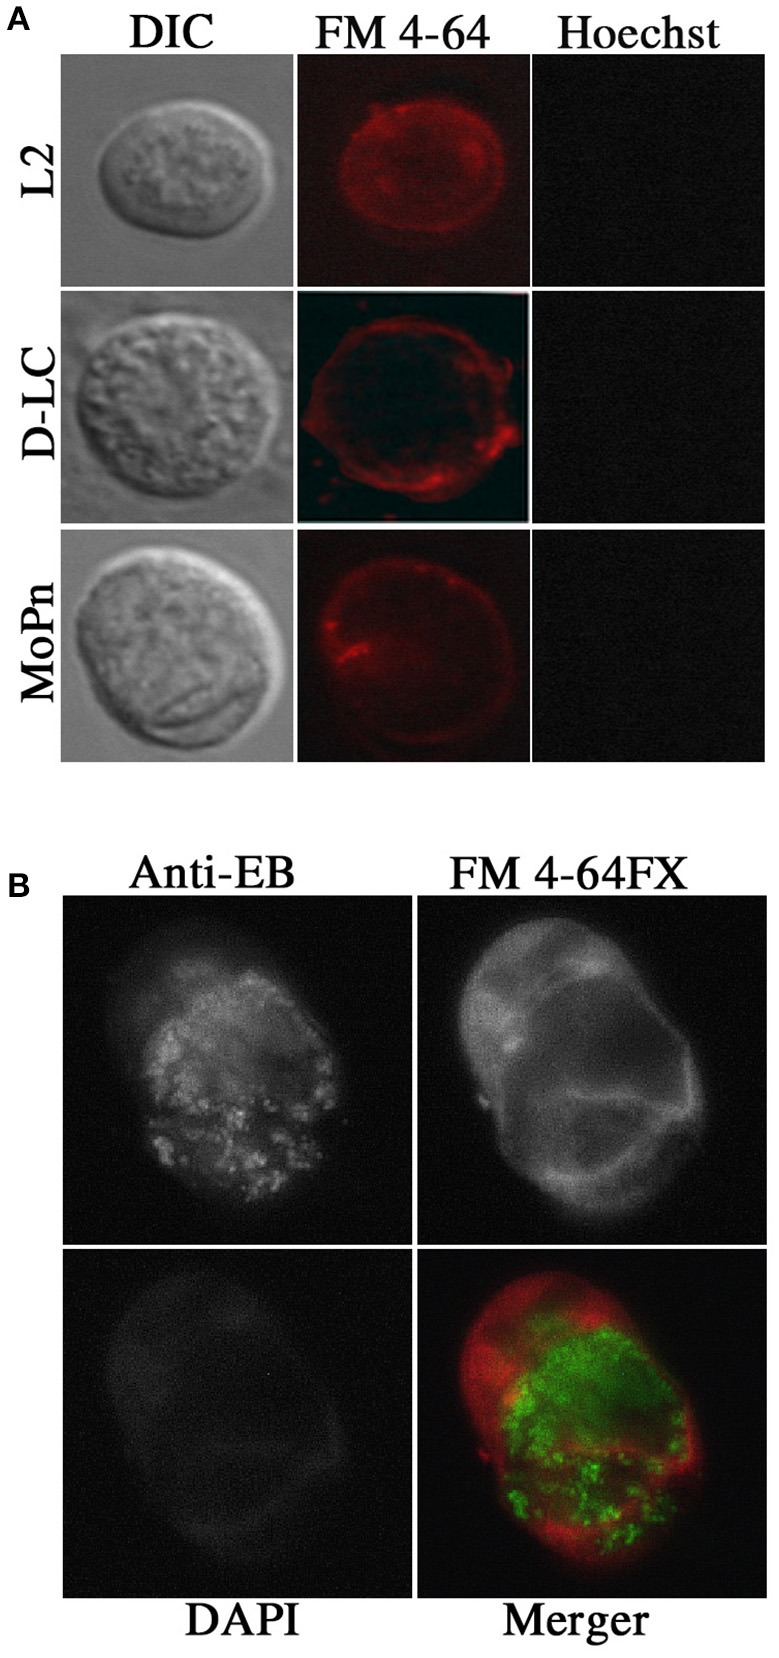
Presence of extrusions in vivo after infection with Chlamydia by live and fixed cell microscopy. (A) Live cell microscopy identified potential extrusions shed from mice infected with each chlamydial strain tested. Olympus Laser Scanning Confocal microscopy was used to obtain DIC, nuclear (Hoechst; blue) and plasma membrane (FM 4–64; red) images on 60X with oil. (B) Fixed cell imaging was used to confirm extrusions shed from the cervicovaginal tracts infected with C. trachomatis L2. Indirect immunoflourescent images of fixed extrusions were obtained using a Leica DMI6000B at 40X magnification. Staining of plasma membrane (FM 4–64 FX; red), L2 EBs (anti-L2; Green), nuclei (DAPI; blue), and a merged image are shown.